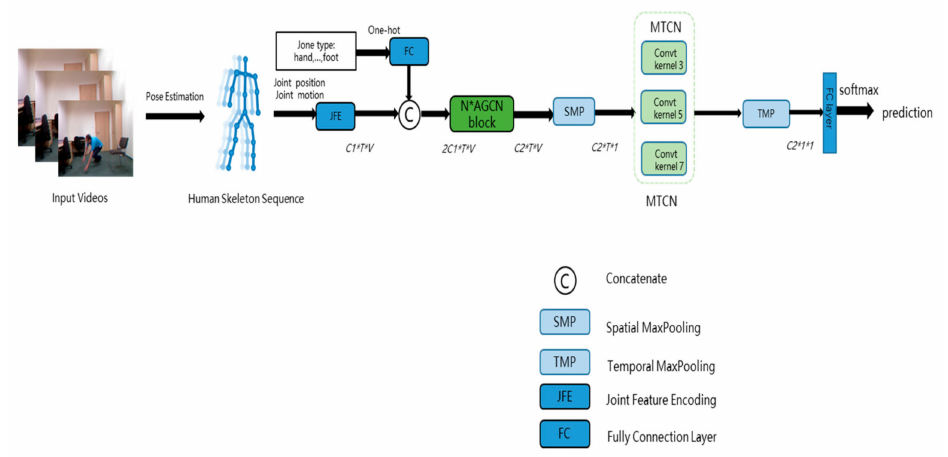
Figure 2. Illustration of the proposed method. It consists of skeleton extraction, a spatial module, and a temporal